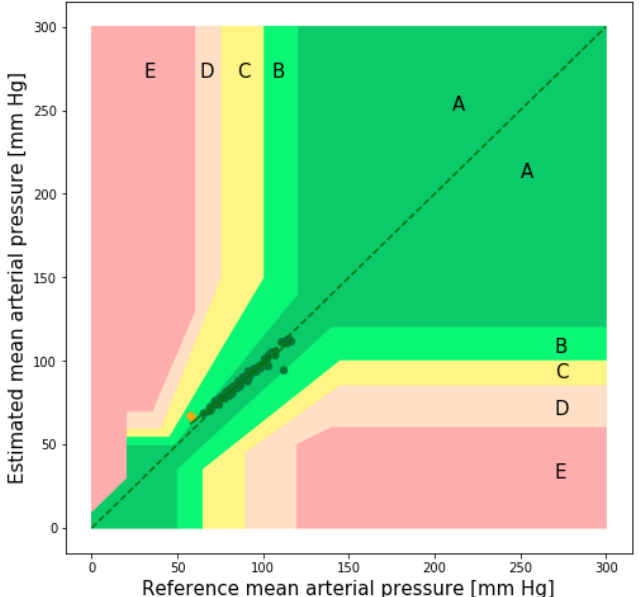
Figure 14. Error grid analysis plot of the MAP (public dataset).